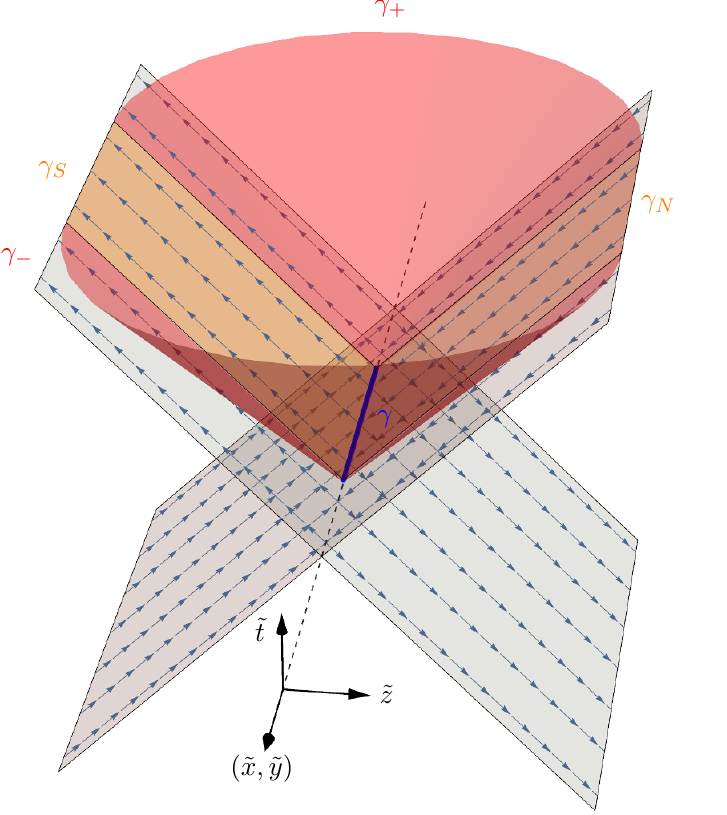
Figure 6 . Ryu-Takayanagi con(cid:12)guration in coordinates (~ t; ~ x; ~ y; ~ z ) in which the bulk modular (cid:13)ow is a boost. The RT surface e A is given by the union of the light sheaf (cid:13) (cid:0) [ (cid:13) N [ (cid:13) S [ (cid:13) + with the surface (cid:13) on the Rindler bifurcation surface (~ x; ~ y ). See (cid:12)gure 7 for an illustration of (cid:13) in the (~ x; ~ y )-plane. The modular (cid:13)ow is tangent to the light sheafs (cid:13) N ; (cid:13) S because they are portions of the Rindler horizons and to (cid:13) (cid:0) ; (cid:13) + because they are half-cones whose transverse sections are hyperbolas which are tangent to the